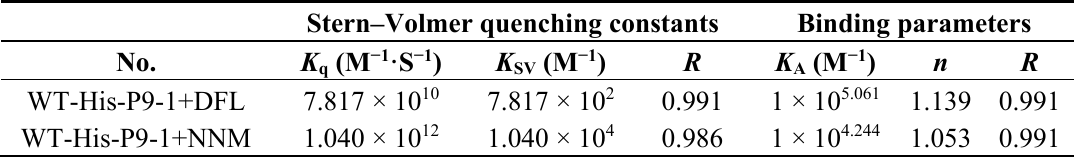
Table 3. Stern–Volmer quenching constants, binding parameters, and thermodynamic parameters of the WT-His-P9-1+DFL and WT-His-P9-1+NNM